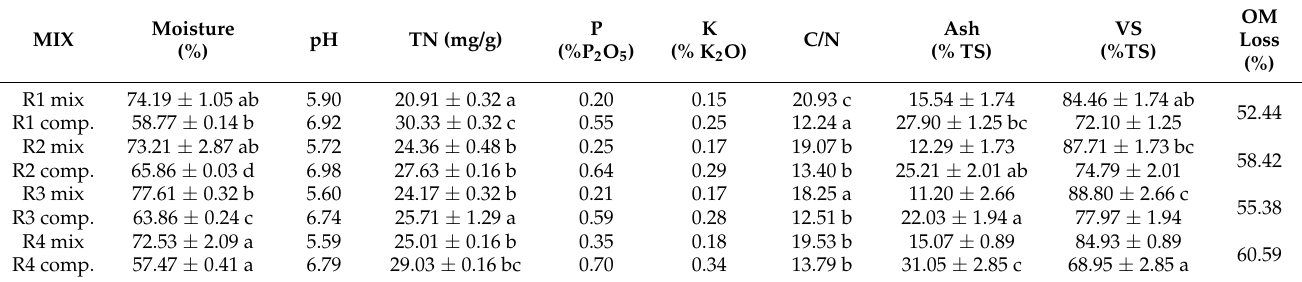
Table 5. Chemical characteristics of mixtures and compost (averages with the same letters are not significantly statistically different; Tukey’s test was c onducted separately for raw mixture (indicated as mix) and compost (indicated as comp.).